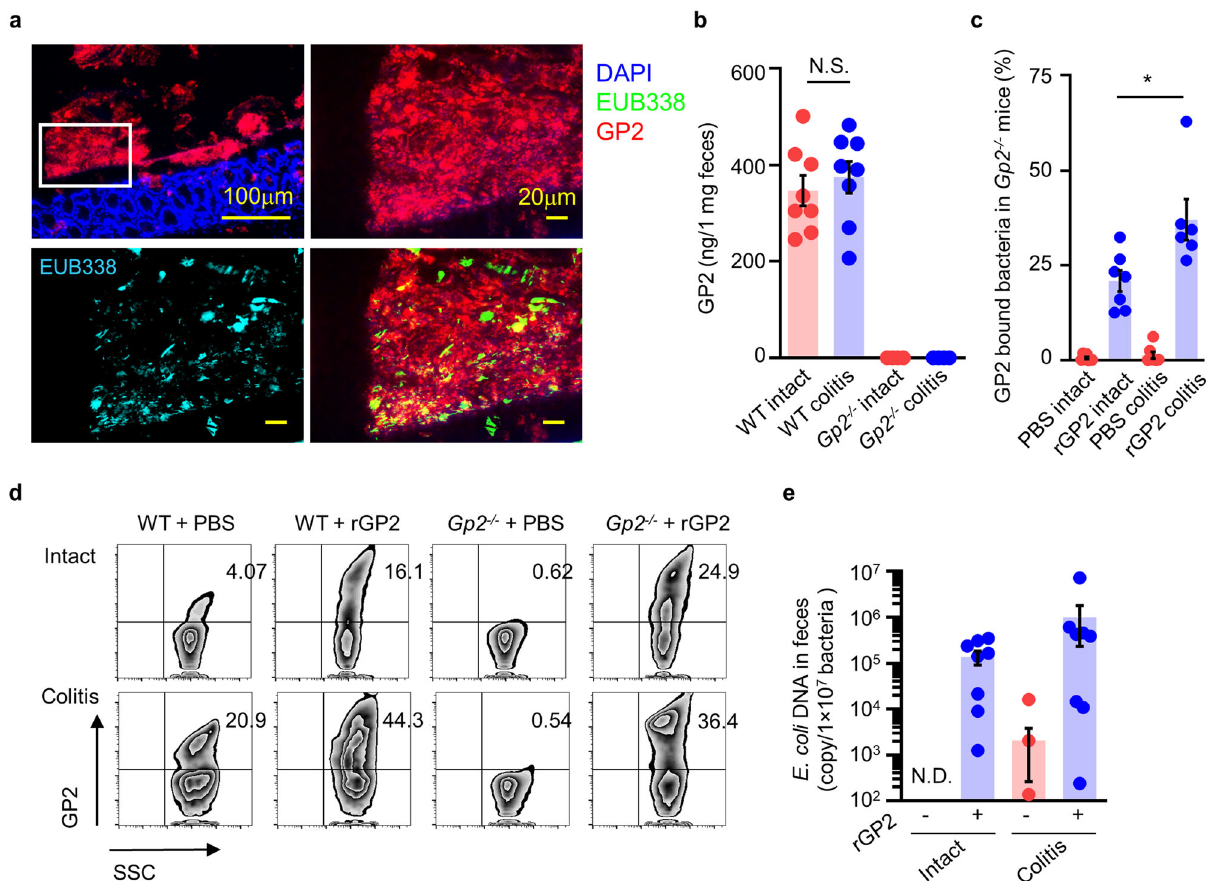
Fig. 7 Recognition of intestinal bacteria by pancreatic GP2. a Luminal contents of colon were stained with GP2 (red) and EUB338 (blue in left bottom and green in right bottom) were shown. Data are representative of three independent experiments. b Fecal unbound GP2 in WT and Gp2 – / – mice with or without acute colitis were measured by ELISA (WT, n = 8; Gp2 – / – , n = 4). N.S. indicates not signi fi cant (two-tailed unpaired t -test). Data are presented as mean values ± SEM. c Percentage of rGP2-bound fecal bacteria isolated from Gp2 – / – mice, PBS and rGP2 Intact n = 7, PBS colitis ( n = 7), rGP2 colitis ( n = 6). * p = 0.017 (two-tailed unpaired t -test). Data are presented as mean values± SEM. d Representative fl ow cytometry analysis of fecal bacteria isolated from WT and Gp2 – / – mice with or without colitis were shown. e E. coli number of non-selected (rGP2 MACS − ) and selected by MACS (rGP2 MACS + ) fecal bacteria ( n = 9 /group). N.D.: not detected. Data are presented as mean values ± SEM. Source data are provided as a Source Data fi